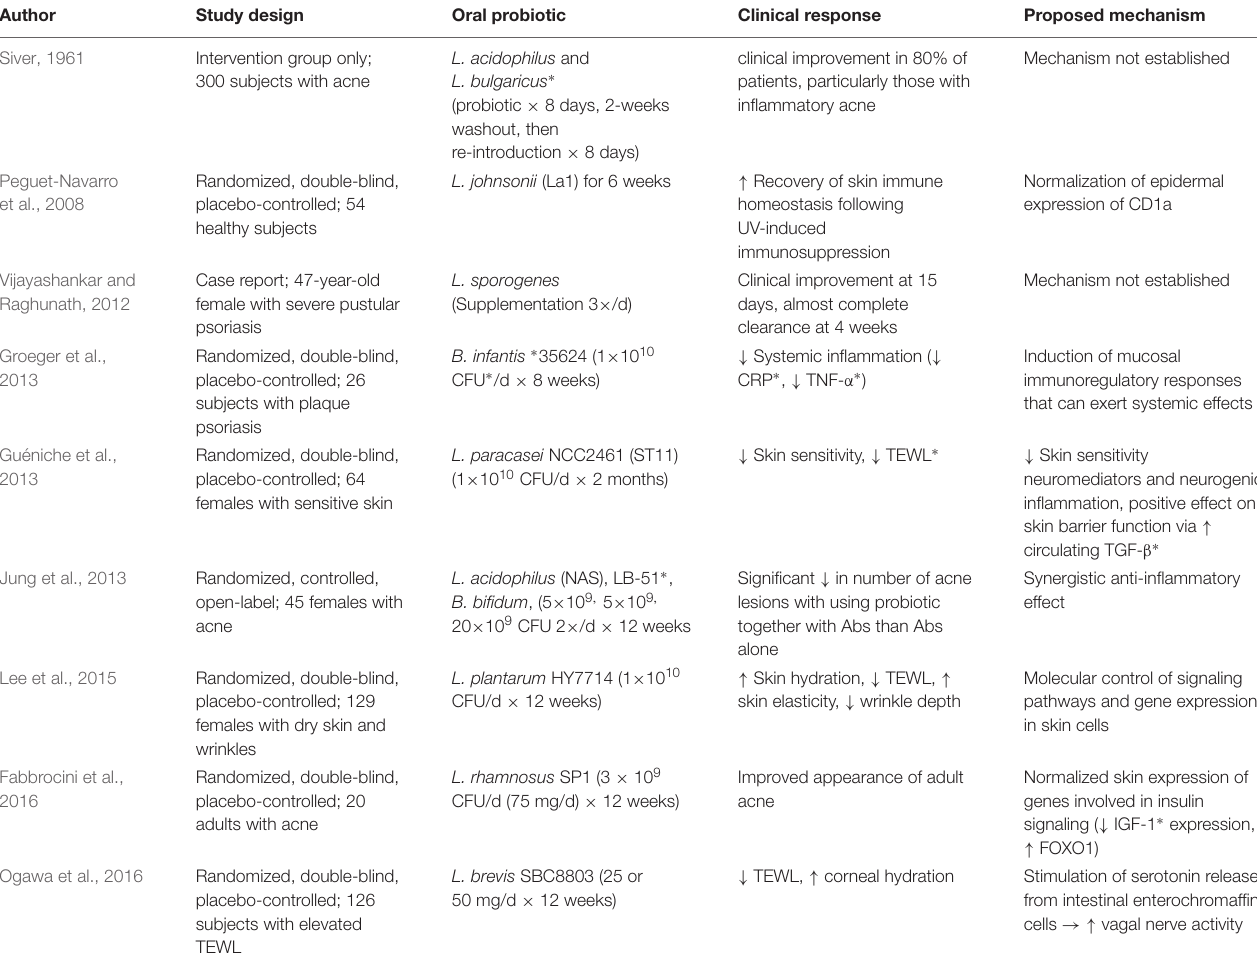
TABLE 2 | Evidence of beneficial probiotic interventions: human